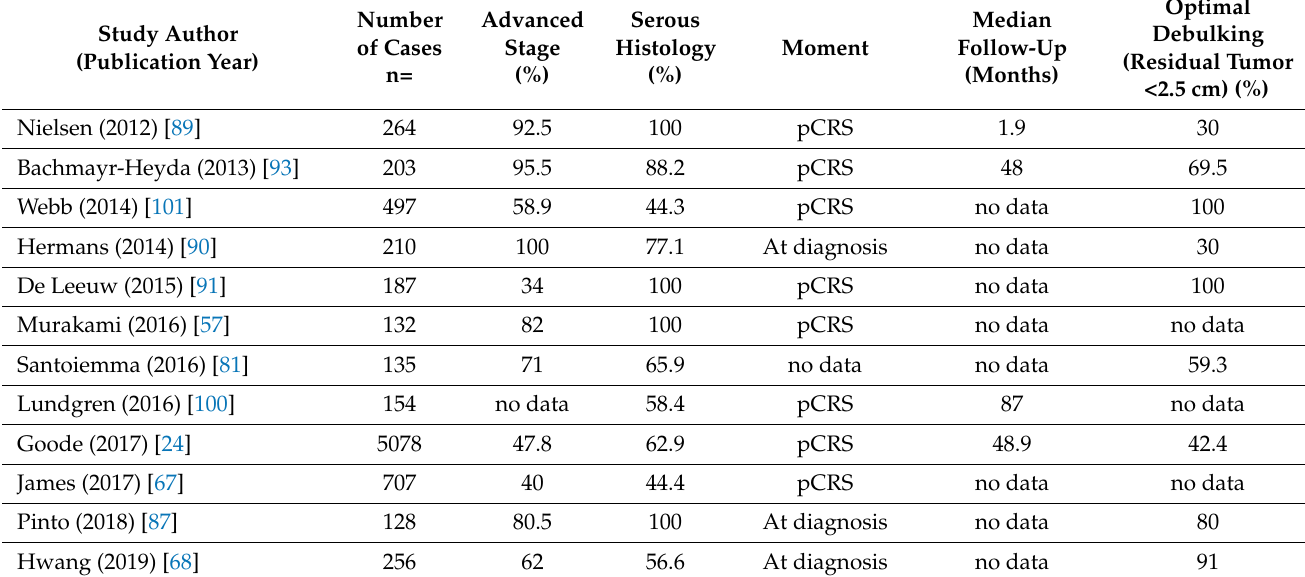
Table 2. Patient characteristics in studies evaluating prognostic